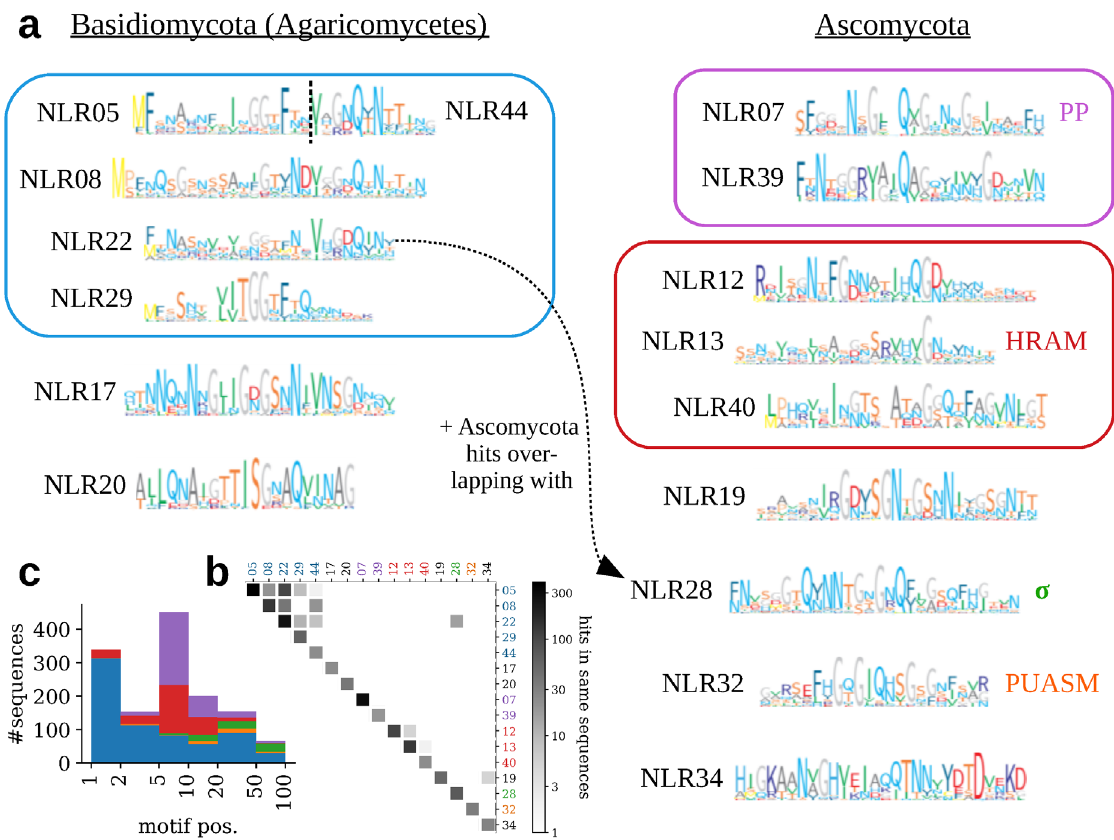
Fig 3. Amyloid-like motifs in short N-termini of NLRs. Clusters of N-termini containing sequences resembling bacterial amyloid signaling motifs were identified using a probabilistic grammatical model [52]. Motifs were extracted with MEME [88] and iteratively refined with profile HMMs. ( a ) Profile HMM-based motif logos—grouped according to overlapping hits in NLR N-termini, as shown in panel ( b ) Overlapping hits in NLR N-termini. See Results and Methods for details. ( c ) Stacked histogram of motif hits positions in NLR N-termini for the five largest motif families, color-coded as in panel